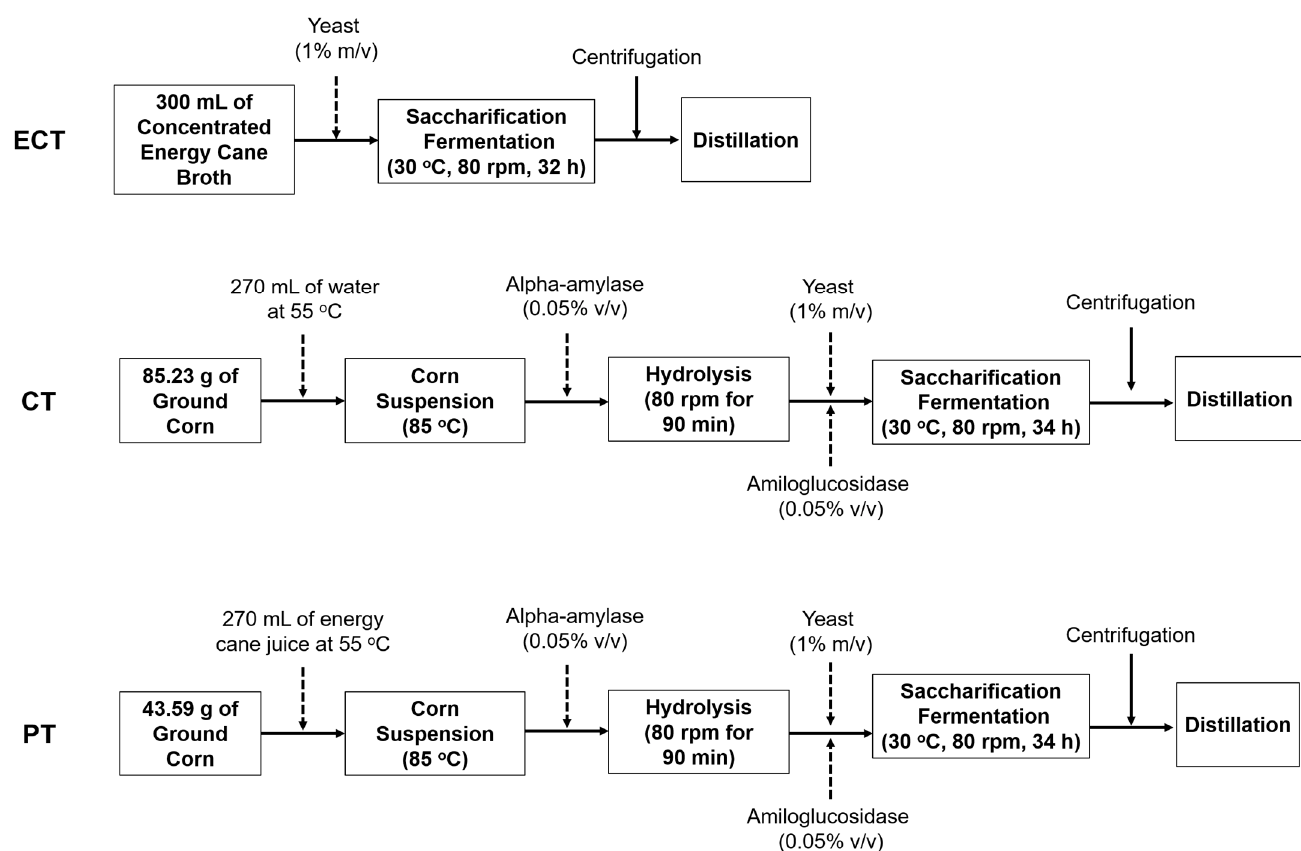
Figure 1. Diagrams summarizing the processes performed in the treatments with energy cane (ECT), with corn (CT), and mixing energy cane juice and corn (PT).